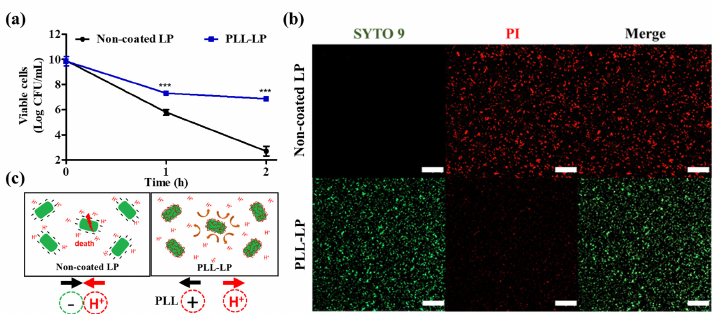
Figure 4. Viability of probiotics in an acidic solution. ( a ) Viable cells after 1 and 2 h of incubation in a pH 2 solution. CFU: colony forming units. The error bar represents the standard deviation ( n = 8). “***” indicates p < 0.001 compared with non-coated LP. ( b ) Confocal laser scanning micrographs of non-coated L. plantarum (LP) and poly-L-lysine (PLL)-coated LP (PLL-LP) after 2 h of incubation in a pH 2 solution. Green fluorescence (SYTO 9) represents the intact membrane of live probiotic cells and red fluorescence (PI) represents dead cells with disrupted membranes. The scale bar represents 40 μ m. ( c ) Proposed mechanism of the enhanced viability of L. plantarum conferred by the PLL coating.